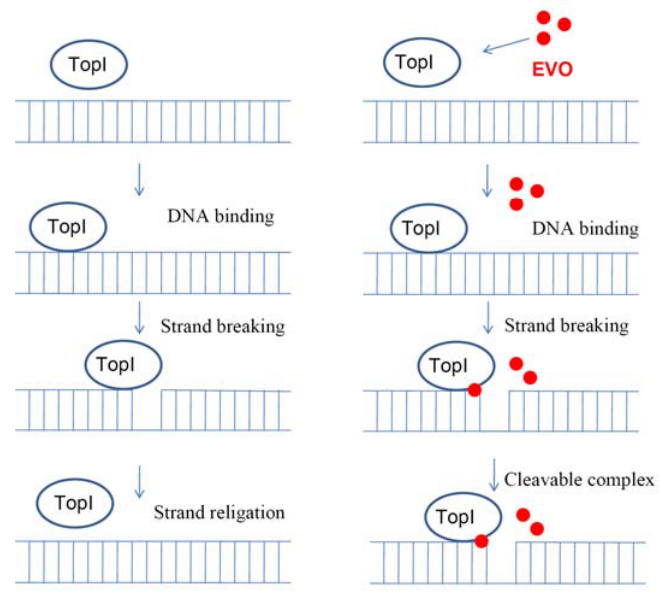
Figure 5. Proposed mechanism of evodiamine (EVO) inhibition of topoisomerase I (TopI) by stabilizing a covalent